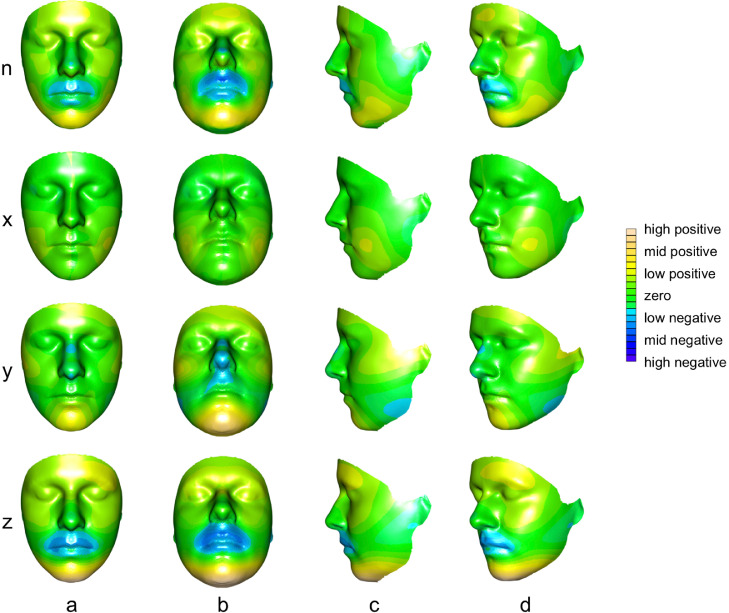
Visualisation of PC1 of non-affine space as control mean with colour-coded directional differences from control mean to bipolar mean (all magnified × 3). Euclidean distances: n, Euclidean distance in normal direction, i.e. along perpendicular direction from each point on the facial surface; x, distance in x-axis direction from each point on the facial surface; y, distance in y-axis direction from each point on the facial surface; z, distance in z-axis direction from each point on the facial surface. Views: (a) coronal; (b) transverse-coronal 22.5°; (c) sagittal; (d) coronal-sagittal oblique; left side of subject shown on right side of image, in accordance with radiological convention. Inset: colour scale for 3D distances where positive [from mid-green, through yellow to brown] indicates values for bipolar cases > controls and negative [from mid-green, through blue to purple] indicates values for bipolar cases < controls. (For interpretation of the references to color in this figure legend, the reader is referred to the web version of this article.)